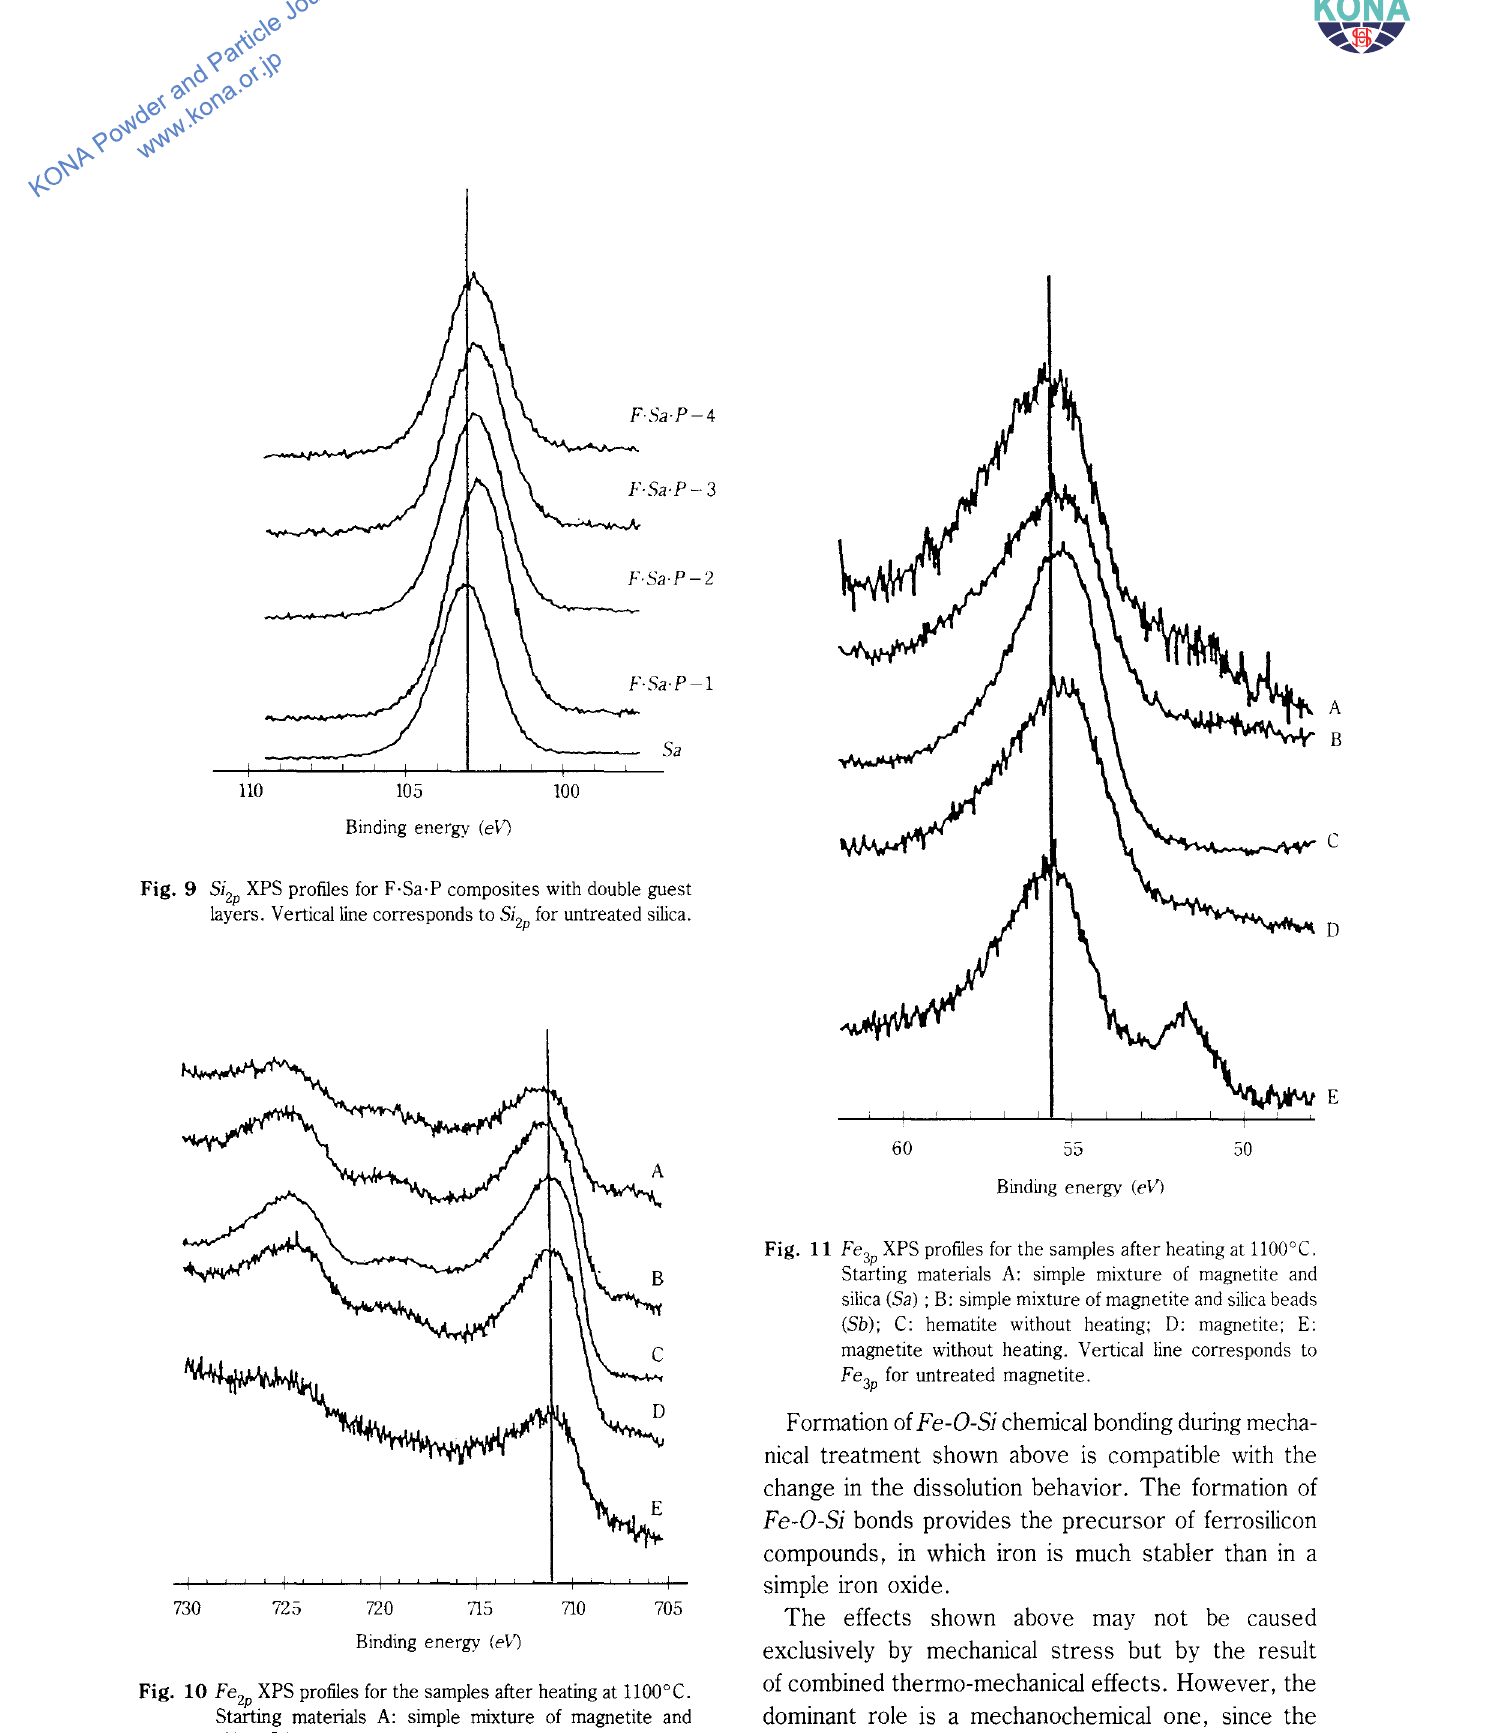
Fig. 10 Fe 2P XPS profiles for the samples after heating at 1100°C. Starting materials A: simple mixture of magnetite and silica (Sa); B: simple mixture of magnetite and silica beads (Sb) ; C: hematite without heating; D: magnetite; E: magnetite without heating. Vertical line corresponds to Fe 2P for untreated magnetite.